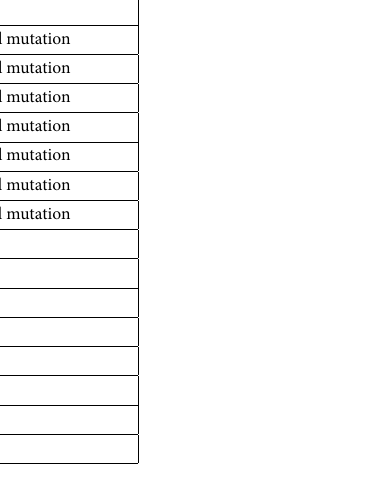
Table 1. Individual characteristics of each